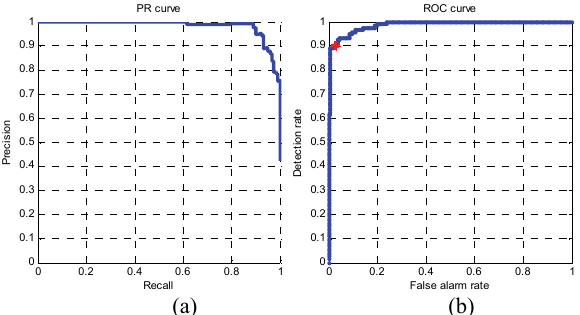
Figure 11. (a) precision and recall curve of the building classification with an average precision is 98%, and (b) the ROC curve of the classification. The red cross marks our decision point which gives a detection rate of 90%, and false alarm rate of